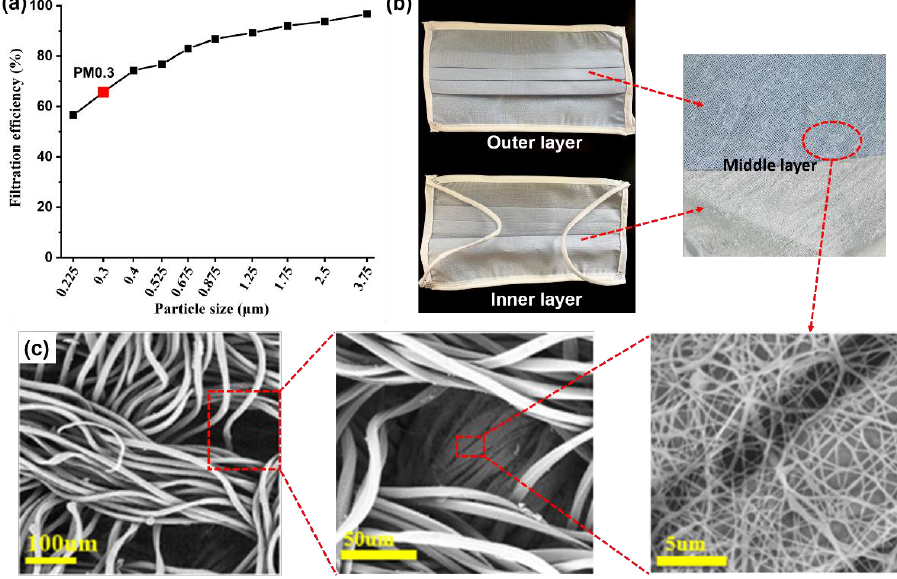
Figure 6. ( a ) The filtration efficiency curve, ( b ) photographs, and ( c ) SEM images of nanofiber film mask. Table 4. Basic parameters of the mask.